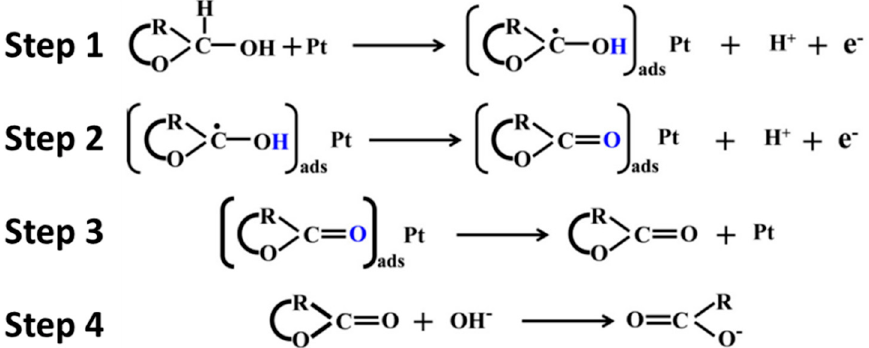
Figure 9. Illustrations for the mechanism of electro-oxidation of glucose by Pt electrode. (Atoms of H and O in blue are the adsorption sites) (Reproduced with permission from [229]. Copyright Elsevier, 2020).